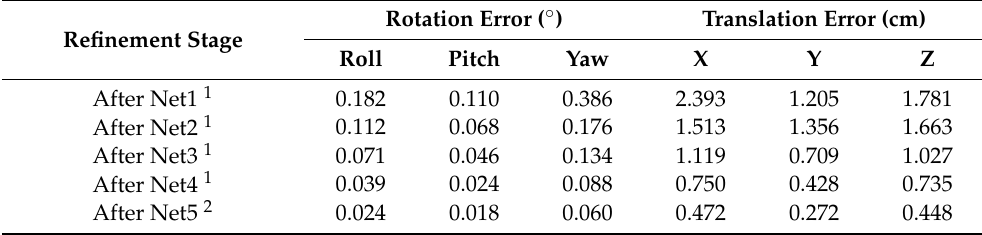
Table 1. Quantitative results of calibration performed on the KITTI dataset without temporal filtering. See footnotes 1,2 for hyper-parameter